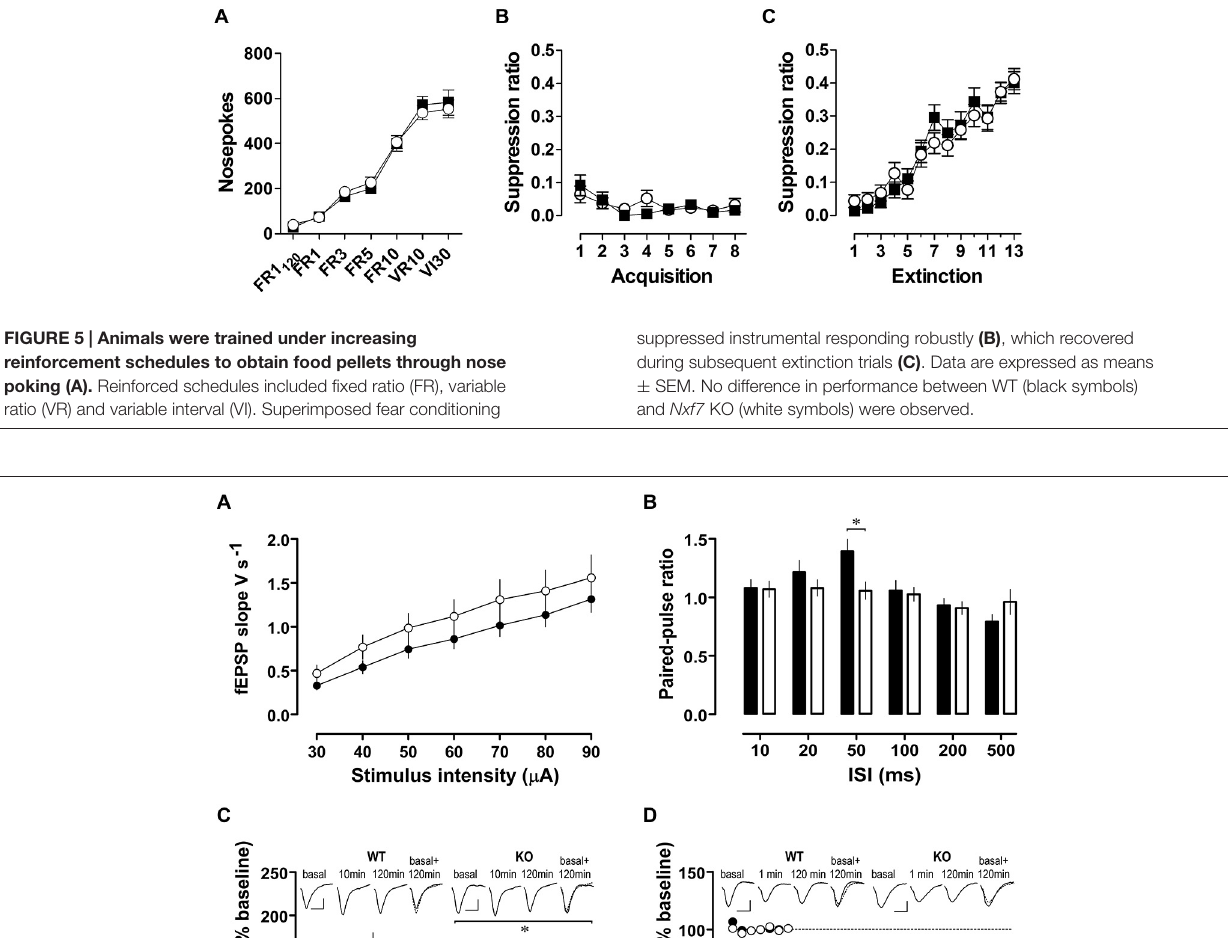
traces collected during baseline recording, 10 min after tetanization (to exclude any confounding influence by post-tetanic potentiation) and 120 after tetanization. Traces on the right side display overlaid traces from baseline recording (full line) and 120 min after tetanization (broken line). Calibration bars indicate 0.5 mV and 10 ms, respectively. (D) LTD induced by low-frequency stimulation of 900 pulses at 1 Hz was similar in Nxf7 KO animals ( n = 12) and in WT ( n = 8). * p < 0.05, RM-ANOVA. See (C) for explanation of insets. Note that for LTD a 1-min-value is